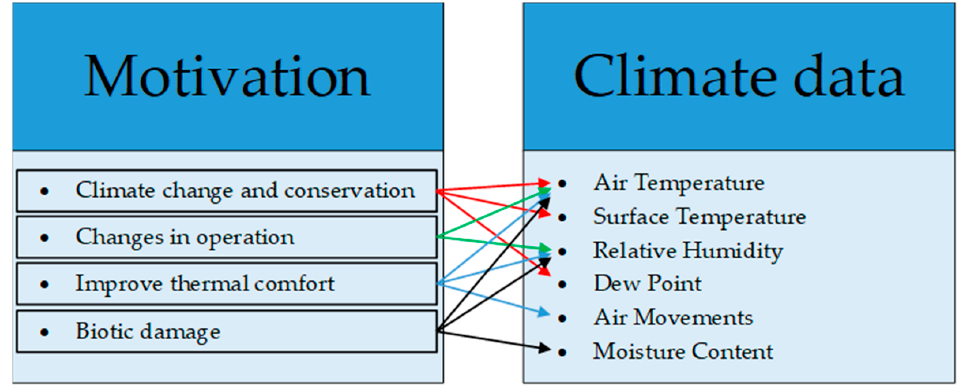
Figure 4. The main motivation of scientific works dedicated to indoor microclimate monitoring and their main monitored parameters. Each of the main motivations is assigned its own arrow colour.